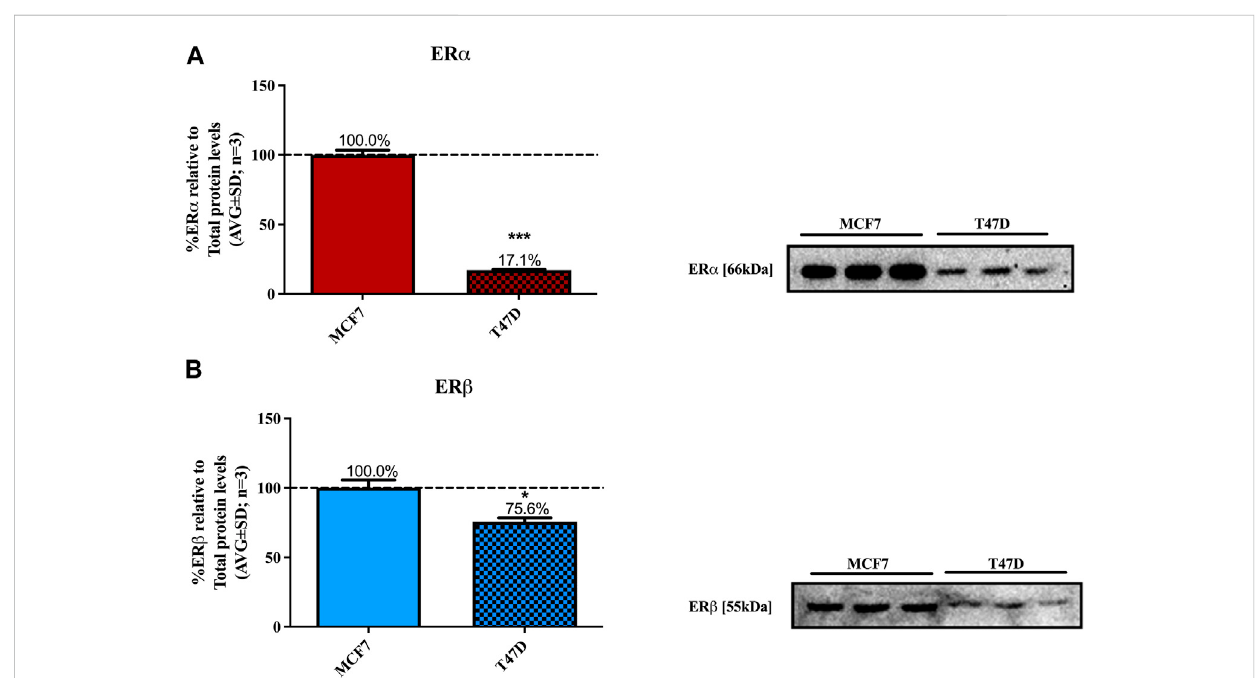
FIGURE 1 BasallevelsofER α andER β proteininMCF7andT47Dcells. MCF7andT47Dcellsweresteroidstarvedfor24 h.Themediawasthenchangedtohigh glucose-DMEM only and the cells incubated for another 24 h, after which ER α and ER β basal protein levels were determined using Western blot. The western blots shown are representatives of three independent experiments for (A) ER α and (B) ER β . For quanti fi cation, the intensity of the ER α and ER β bandsweredeterminedwithMyImageAnalysissoftware,afterwhichtheobtained valueswerenormalizedtototalproteincontentandexpressedas a percentage (AVG ± SD) of MCF7 ER α and ER β protein levels, which was set at 100% (black dotted line). WB is not an absolutely quantitative technique (i.e., the absolute concentrations of proteins cannot be ascertained) only the relative amounts of a protein may be compared between cell lines. Furthermore, as two different antibodies were used for ER α and ER β we cannot directly compare the absolute levels for the ER subtypes. Thus, we chose to normalize the ER subtype levels to that in MCF7 cells. Statistical analysis was done using unpaired t -test (* p < 0.05, *** p < 0.0001) to evaluate the statistical difference between the basal levels of ER α and ER β protein in MCF7 and T47D